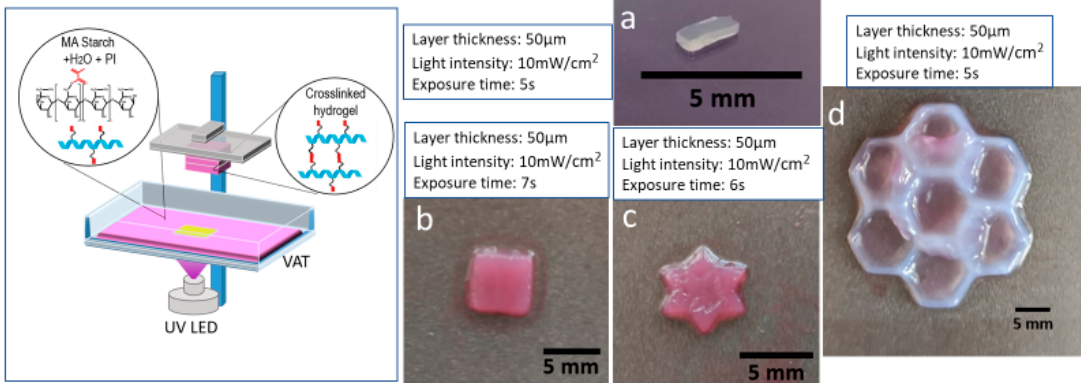
Figure 7. 3D DLP printed hydrogels: ( a ) smallest hydrogel printed without the use of dye [1.5 mm × 0.5 mm × 2 mm]; ( b , c ) simple geometries [5 mm × 5 mm × 1 mm]; and ( d ) complex flower geometry [24 mm × 24 mm × 4 mm].